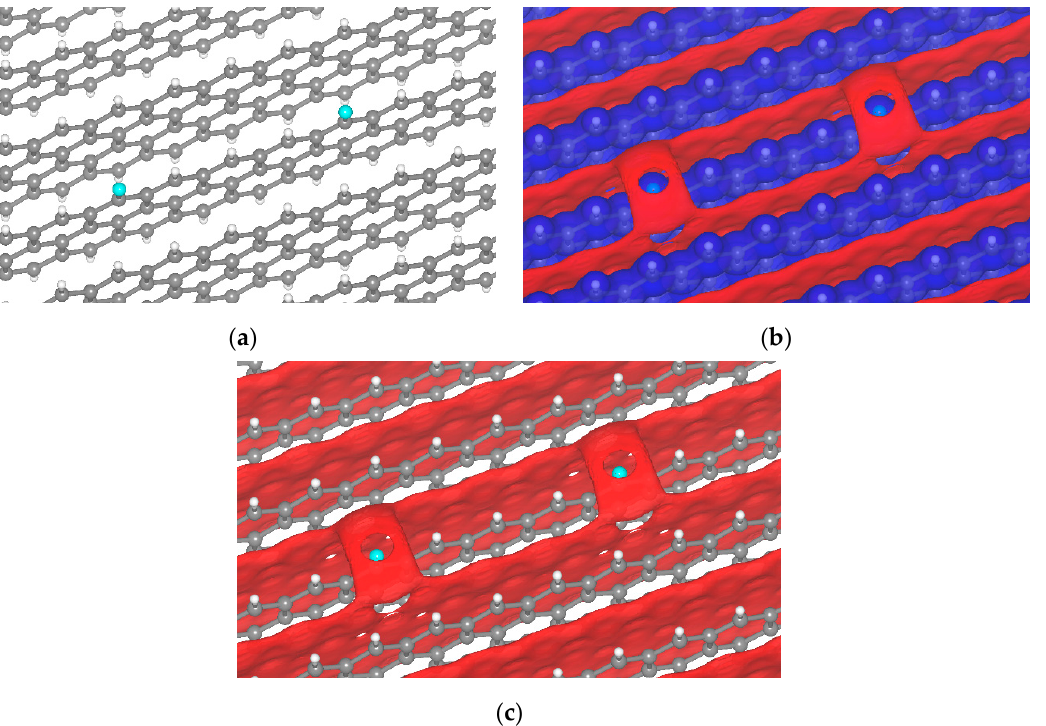
Figure 7. Passivated H-terminated (001) surface. ( a ) Crystal of passivated graphite with fluorine. Isopotential surface of graphite with a fluorine atom, separated between negative (red) and positive (blue) regions; ( b ) graphite atomic conformation and isopotential ±2.8 V; and ( c ) graphite atomic conformation and isopotential − 2.8 V.